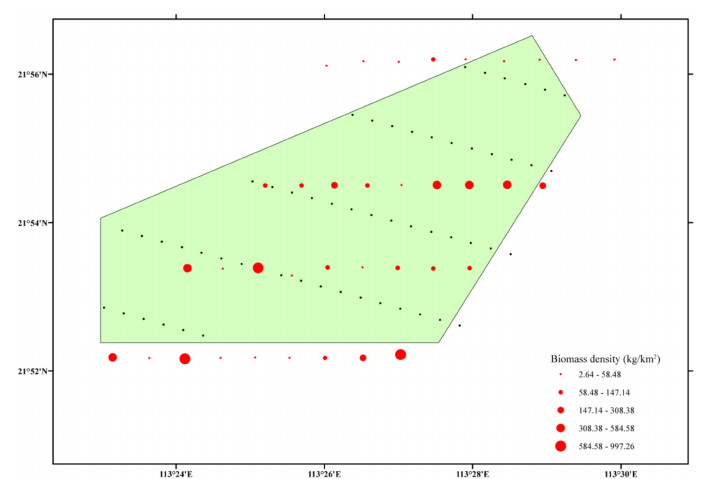
Figure 3. Distribution of fish biomass density in the Jinwan offshore wind farm area.